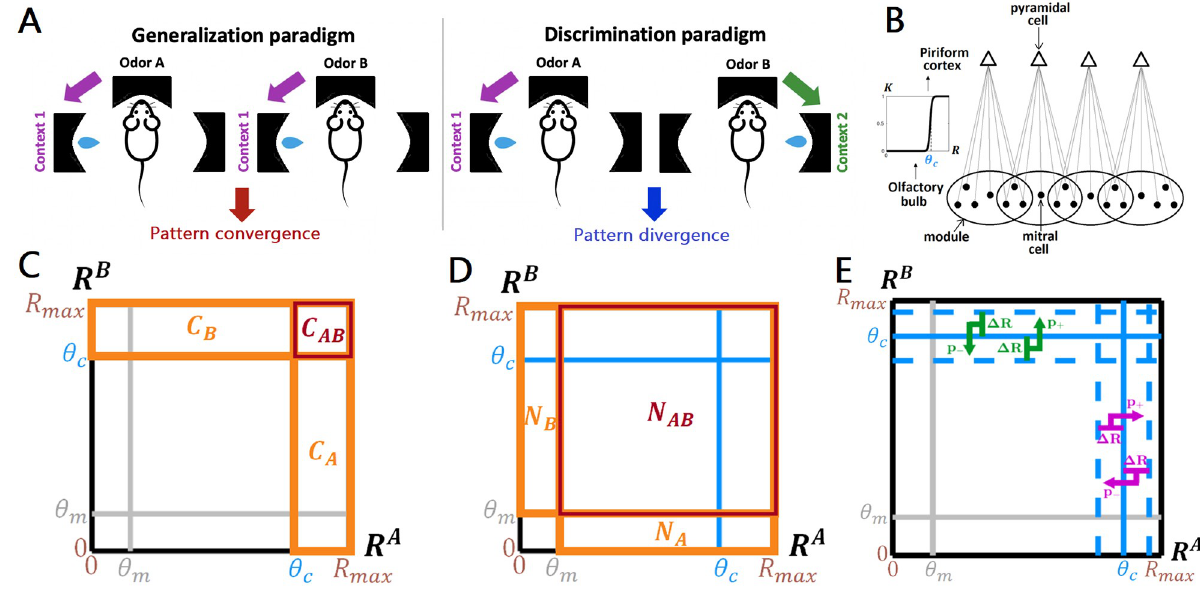
Fig 1. A statistical mechanism for context-induced pattern convergence and divergence in the olfactory system. ( A ) Context is information present in the environment that is salient to perception and behavior, e.g. the location of a reward associated with an odor. Left: in two-alternative forced-choice tasks, when distinct odors are associated with the same context (e.g. a left reward port), animals learn to generalize their choice (approaching the left port) across odors; after training, the neuronal ensemble responses to the odors in the PC are more correlated (pattern convergence, [19]). Right: when odors are associated with alternative contexts (e.g. opposite reward ports), animals learn to discriminate the stimuli and make different, odor-specific, choices (approaching the left versus right port); after training, the cortical ensemble responses are less correlated (pattern divergence, [19]). ( B ) In the statistical model, the olfactory bulb is represented as an ensemble of “modules” (black circles), with each module defined as the set of MCs (black dots) that project to the same cortical neuron (triangle), and the activation probability of cortical cells is a threshold function of the modules’ responses. ( C ) A geometrical interpretation of Eq 5. The square represents the space of module responses to two odors (A and B). The number of cortical cells activated by odor A ( C in Eq (5)) is equal to the number of modules with responses higher than the cortical activation threshold θ A likewise for C B (orange rectangle labeled C B ) and C AB (red rectangle). ( D ) N A (orange rectangle labeled N A ), N B (orange rectangle labeled N B ), and N AB (red rectangle) represent the number of modules responsive to odor A, odor B, or both odors, respectively. Because of the assumption of uniformity, C A , C B , and C AB can be re-expressed in terms of these values (Eq 1). ( E ) Stochastic feedback representing contextual changes in the distribution of module responses. Modules with responses to either odor within Δ R from the cortical activation threshold and targeted by positive/negative feedback (with probabilities p + and p − , respectively) are brought above/below the cortical threshold, changing similarity between the cortical odor representations (Eq 7).